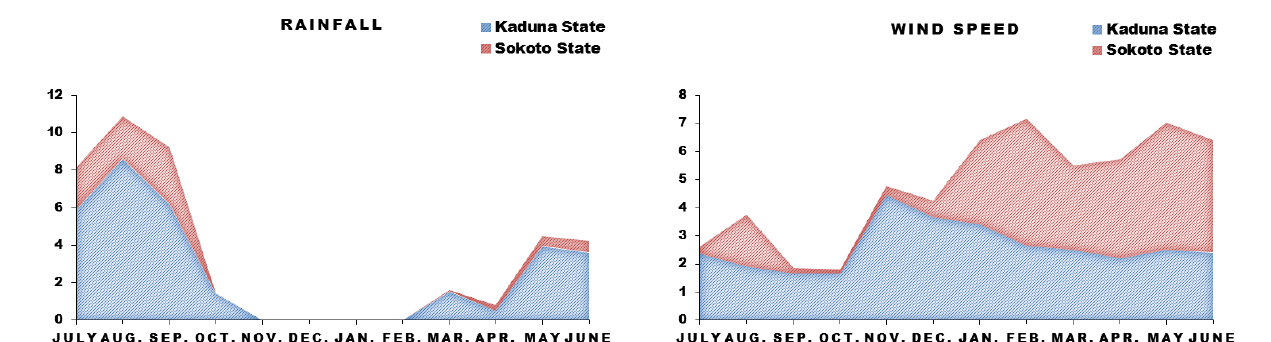
Fig. 6. Mean monthly rainfall values (mm) in Kaduna and Sokoto States